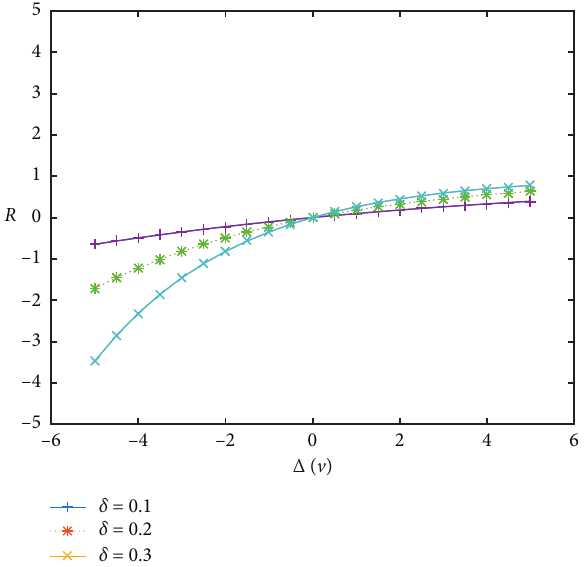
Figure 1: Regret-rejoice function, R Δ υ